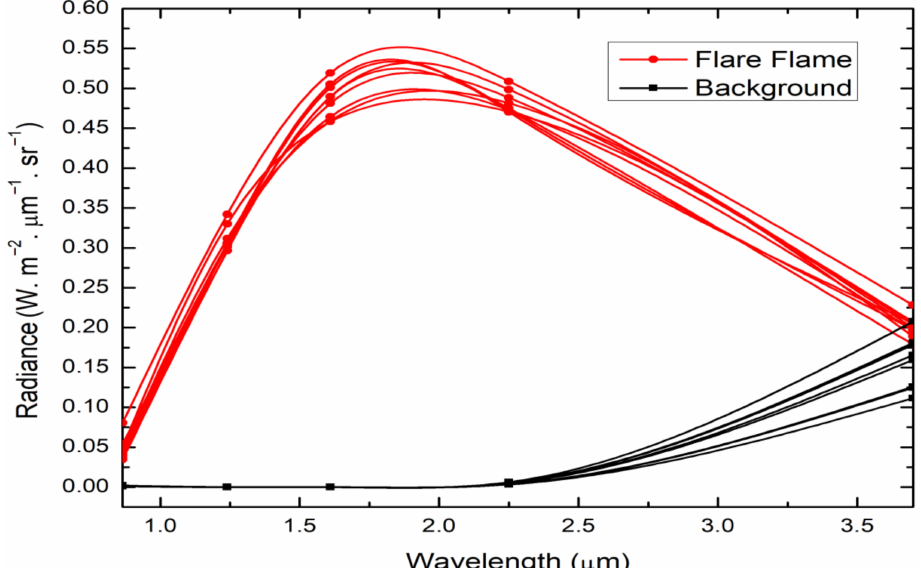
Figure 4. The used sets of flare flame and background spectra, with spectral variability, used for creating synthetic data (flare flame spectra are obtained with 1550 Kelvin for the temperature and 1.5 × 10 − 5 for the